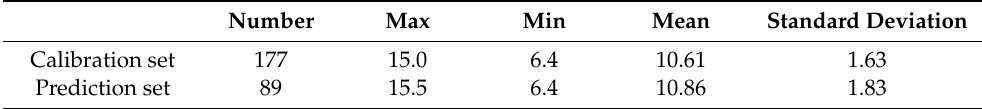
Figure 2. Spectrum of soluble matter content in peach samples. A total of 266 samples were divided into two subsets with the ratio of 2:1 by a typical duplex method as shown in Table 1. One is the calibration subset, used to construct and train the calibration regression model, and the other one is the prediction subset, used to validate the feasibility of the developed regression model. The mean of SSC values in these two subsets are close, indicating that the homogeneous distribution of divisions is made to evenly develop the regression model. Table 1. Distribution of soluble solids content in peach